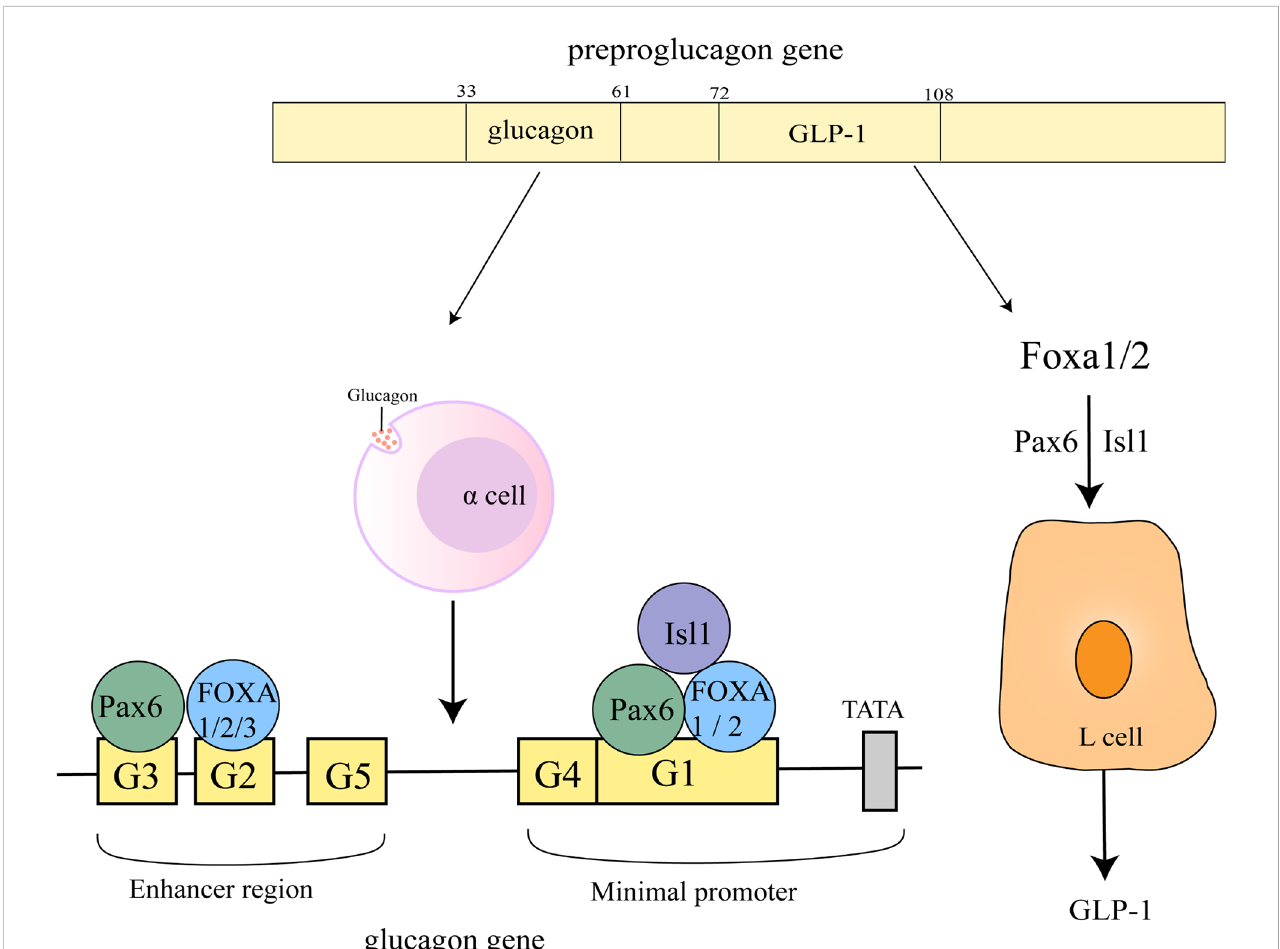
FIGURE 4 Regulation of glucagon gene promoter and GLP-1 by FOXA. The sequences of glucagon and GLP-1 correspond to 33-61 and 72-108 of the proglucagon sequence (53). On the glucagon gene promoter, FOXA1 and FOXA2 bind to the G1, G2 element, FOXA3 is located on the G2 element, Pax6 is located on the G1, G3 element and Isl1 on the G1 element. FOXA1 and FOXA2 act upstream of ISL-1 and Pax6 to regulate L-cell differentiation, control GLP1